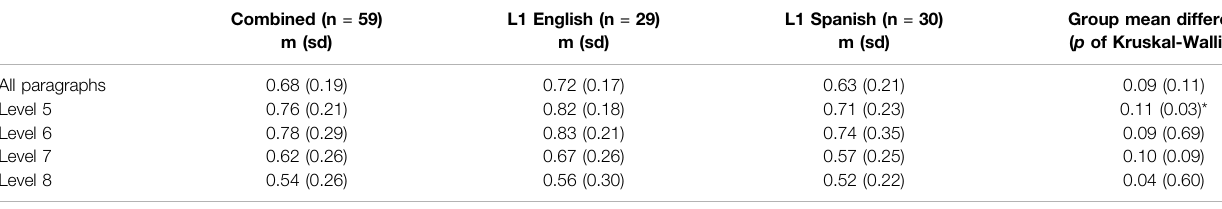
TABLE 5 | Paragraph comprehension accuracy.